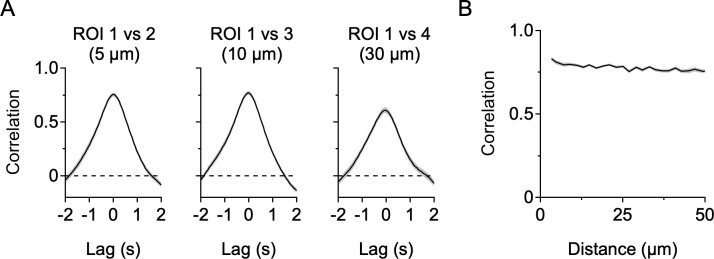
Stimulus-driven correlations between DSGC dendritic sites.(A) Correlations between the raw Ca2+ signals from the ROIs shown in Figure 3 (without mean subtraction). (B) Correlation between ROIs as a function of cable distance. Here, since Ca2+ signals arise at all sites during the period of stimulus presentation, the spatial decay of the site-to-site correlations is minimal.Figure 3—figure supplement 1—source data 1.Stimulus correlation measurements.